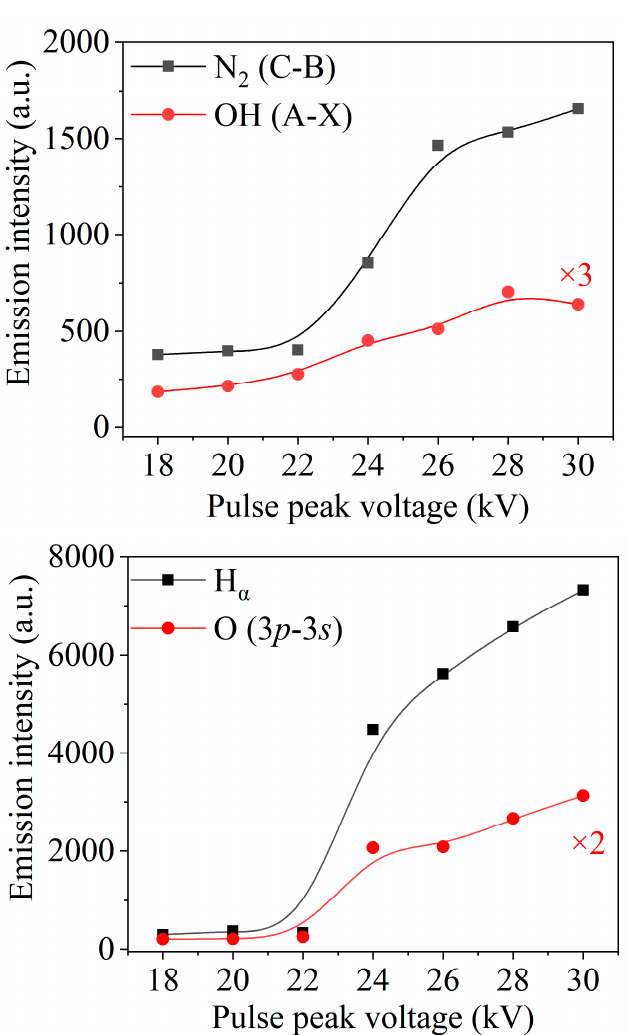
Figure 5. The emission intensities of OH (A 2 ∑ → X 2 ∏ ), N 2 (C 3 ∏ u → B 3 ∏ g ), H α , and O (3p 5 P → 3s 5 S 0 ) varying the pulsed voltage.